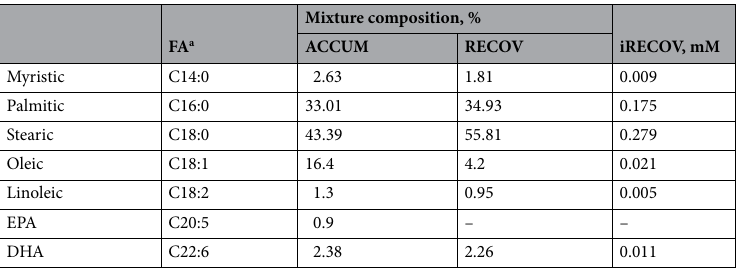
Table 1. Treatment composition of fatty acids (FA) of physiologically representative mixtures present in circulating serum [liver lipid accumulation (ACCUM) and liver lipid clearing (RECOV)] and concentration of individual FA physiologically present in circulating serum in dairy cows at 0.5 mM of RECOV (iRECOV). a C14:0, C16:0, C18:0, C18:1 n-9, C18:2 n-6, C20:5 n-3, and C22:6 n-3 are abbreviated as C14:0, C16:0, C18:0, C18:1, C18:2, C20:5 and C22:6 in the table for conciseness.